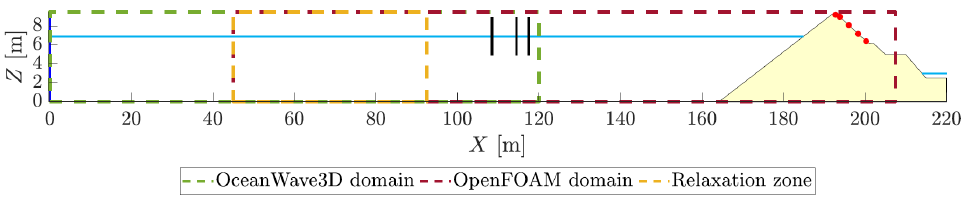
Figure 5. Overview of OceanWave3D and OpenFOAM® domain, with X [m] and Z [m] the horizontal and vertical position in the